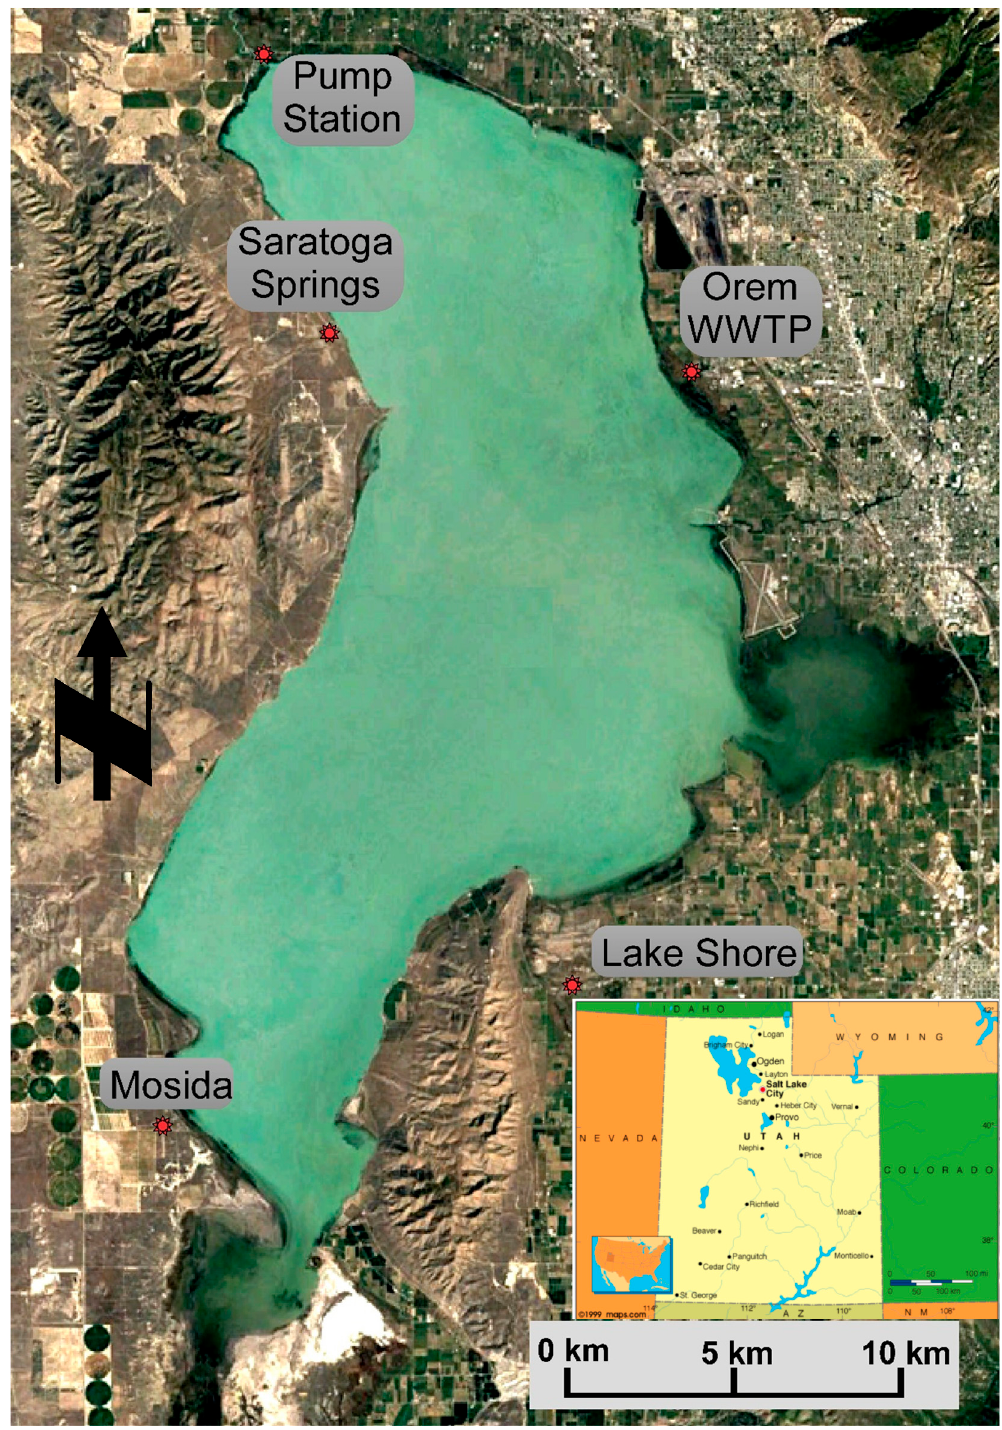
Figure 1. Utah Lake is a large freshwater lake in northern Utah which has a surface area of about 360 square km (140 square miles) with an average depth of 2.7 m (9 feet) and a maximum depth of only 4.3 m (14 feet). Also shown on the map are the five atmospheric deposition sampling sites used in this study.